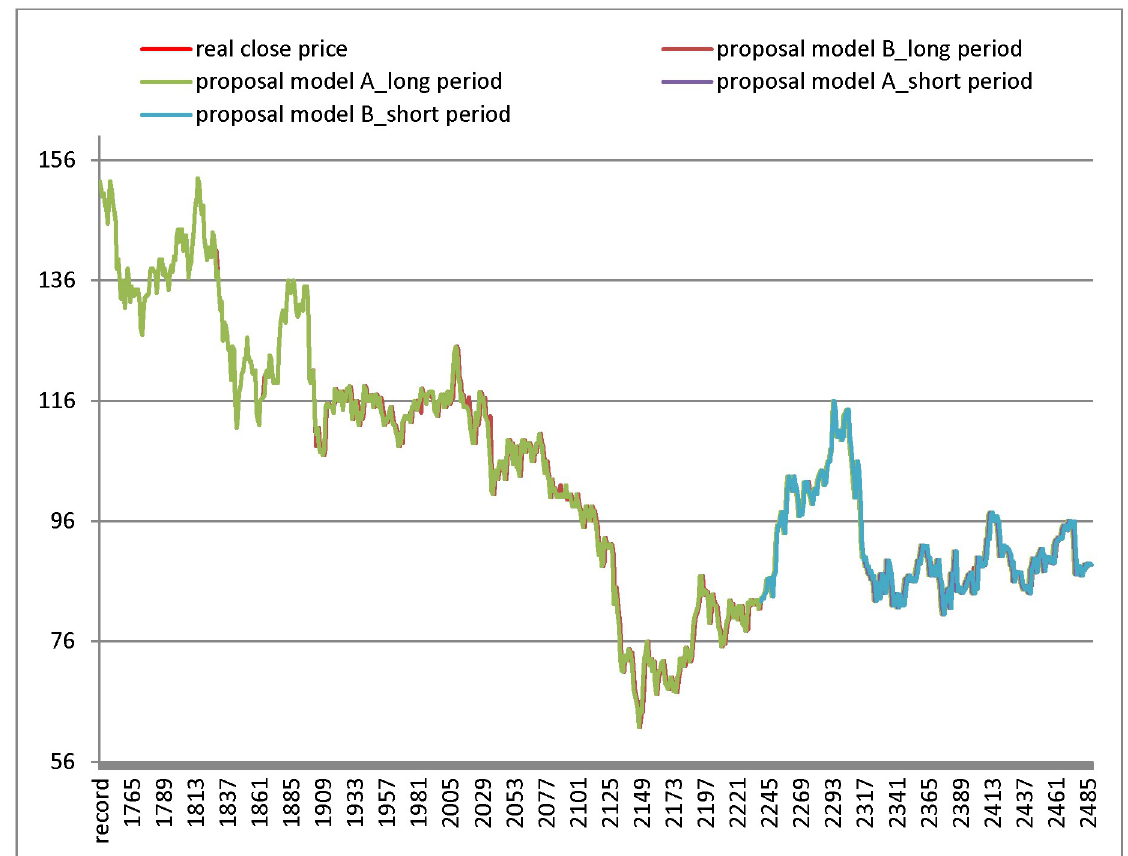
Fig 4. Results of forecasting short and long test period for Hon Hai